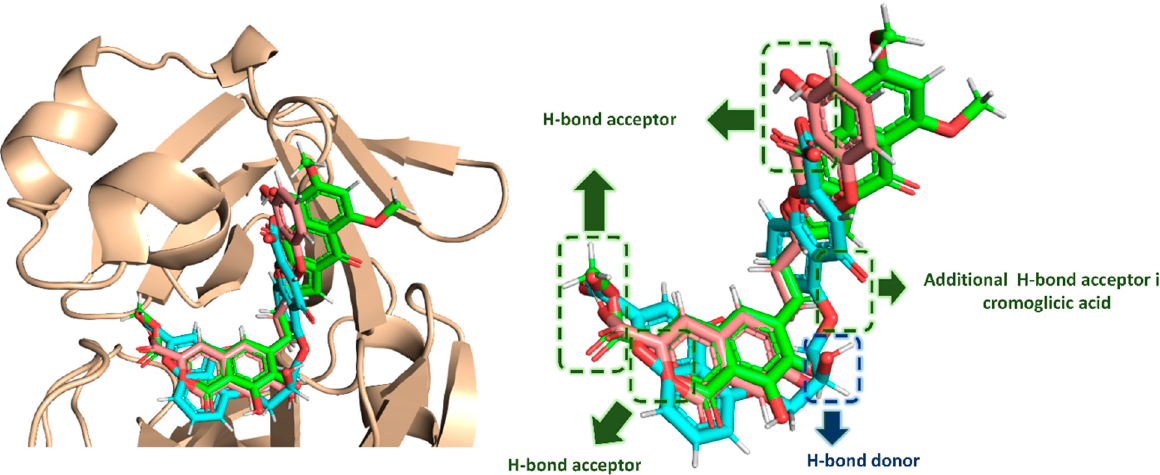
Figure 6. Docking pose alignment of α -rubromycin (green color), ScafA (red color), and cromoglicic acid (cyan color). This alignment shows that the three compounds have a good alignment and share the same pharmacophoric features.